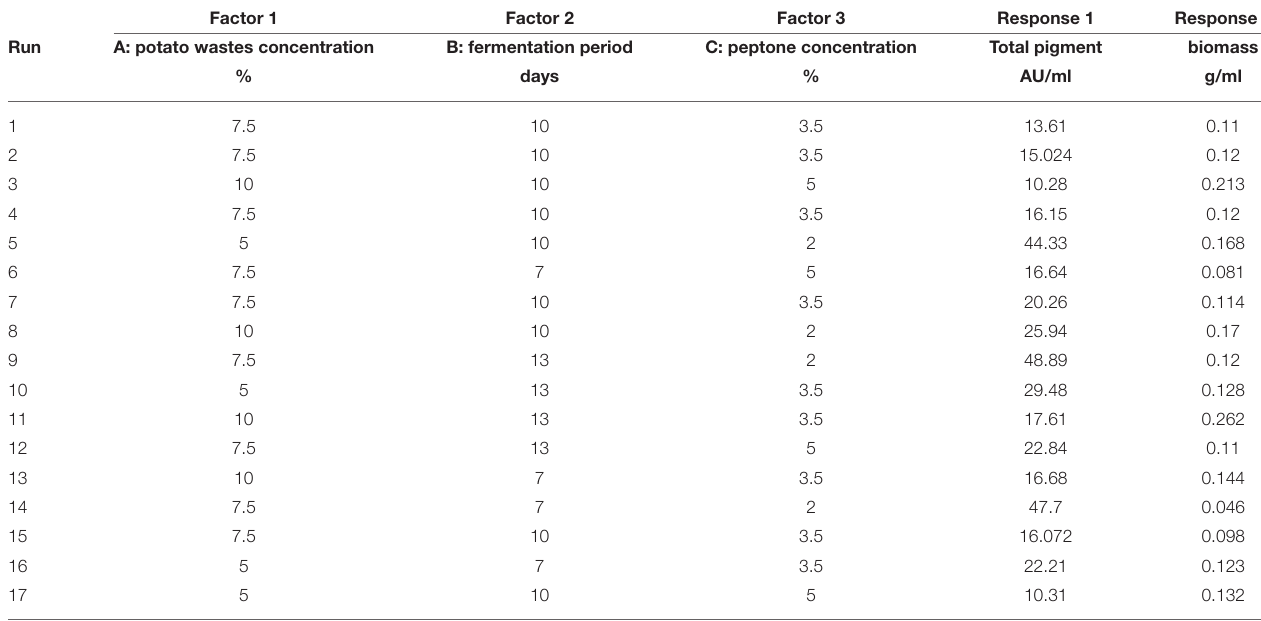
TABLE 3 | A Box-Behnken experimental design of independent variables and actual results of response (1) total pigment and response (2) biomass produced by Monascus purpureus Went NRRL 1992. Factor 1